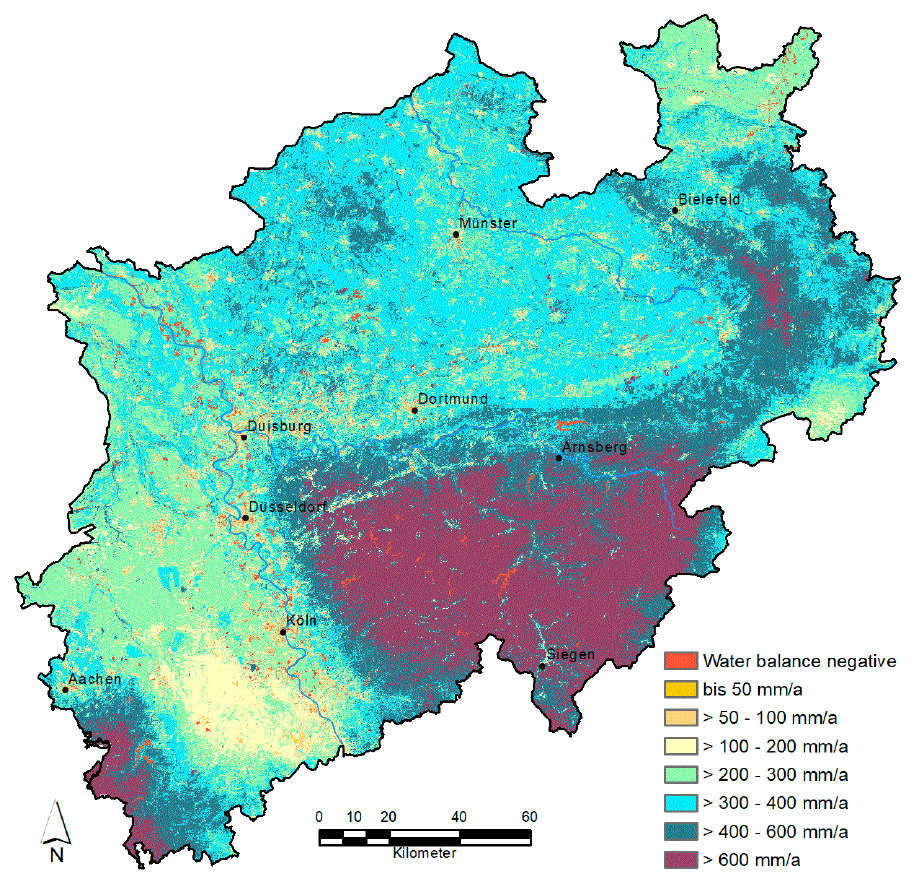
Figure 2. Mean long-term leachate rate of the hydrologic period of 1981–2010.